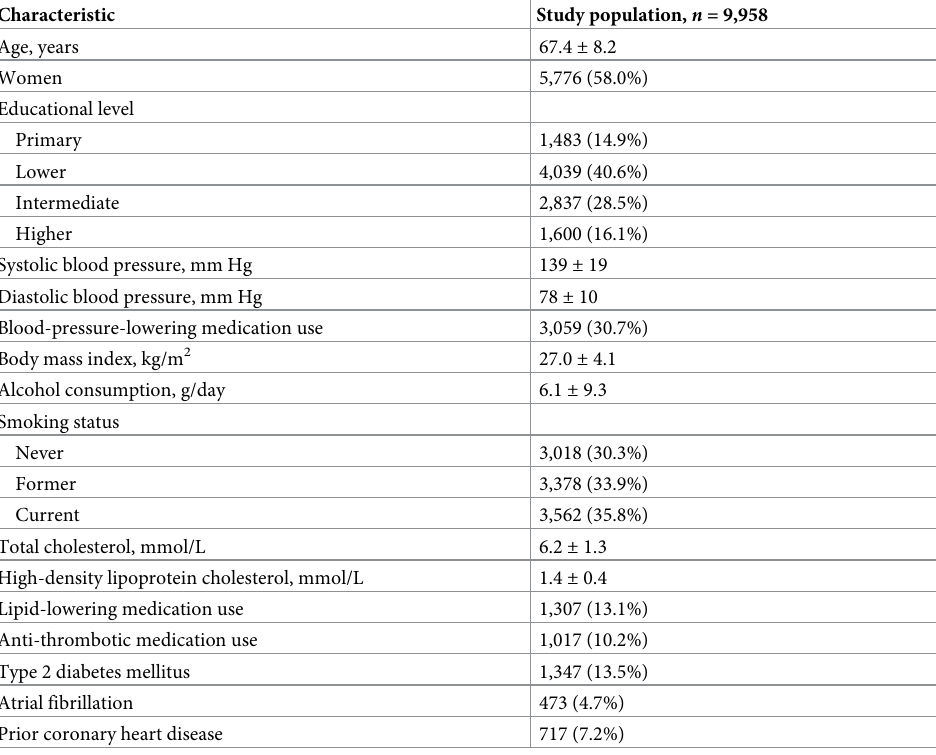
Table 1. Baseline characteristics of the study